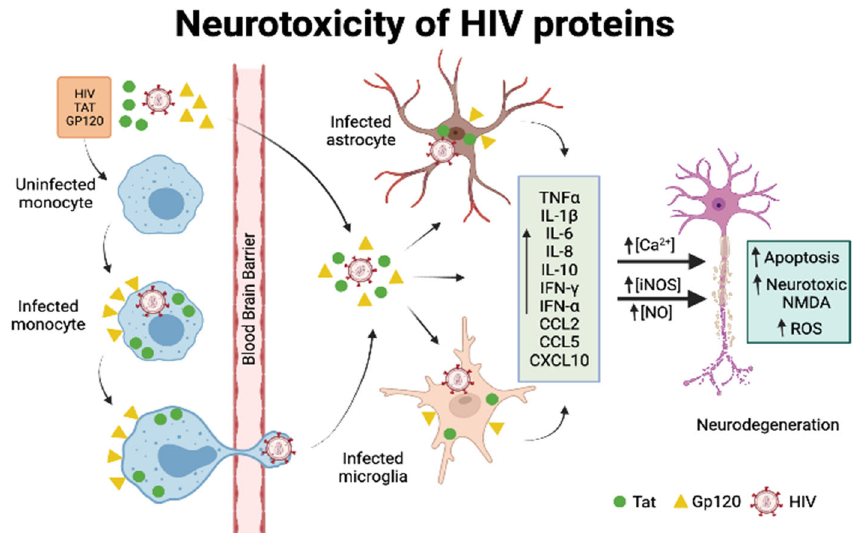
Figure 1. Neurotoxicity of HIV proteins. HIV proteins Tat and Gp120 cross the blood-brain barrier either directly or via infected monocytes and subsequently contribute to neurodegeneration either directly or indirectly by infecting glial cells and regulating the proinflammatory gene expression. The figure was created using BioRender